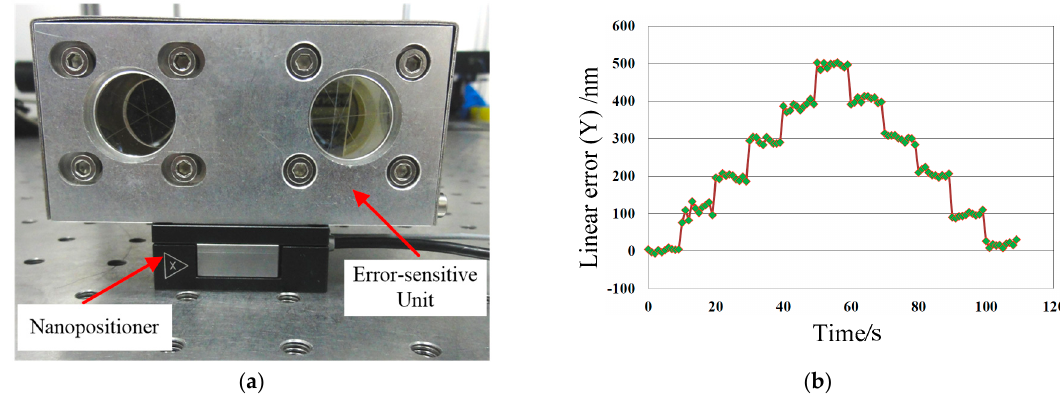
Figure 4. Resolution test: ( a ) Experimental setup; ( b ) Experimental results.